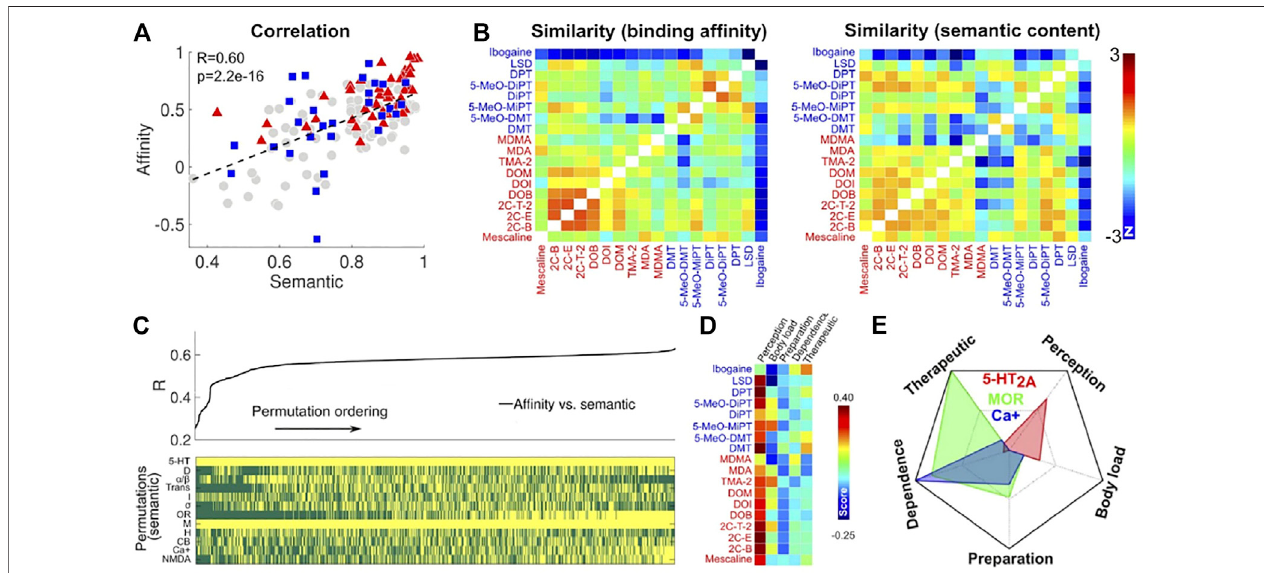
FIGURE 6 | The semantic similarity of subjective reports is correlated with the similarity of binding af fi nity pro fi les for 18 psychedelic tryptamines and phenethylamines (panel (A) , left), from Zamberlan et al., 2018. This can be appreciated by direct visual inspection of the corresponding similarity matrices (panel (A) , right). Panel (B) shows the correlation (with the color code representing Z scored correlations) between semantic and pharmacological similarity matrices, with the latter computed using information from different receptor subsets, allowing to identify an optimal group of receptors to explain the semantic content of the reports. The principal components of the reduced ranked term-document matrix represent recurrent topics in the corpus, with variable prevalence among the psychedelic drugs under study (panel (D) ). In this panel, the color code indicates the load of each LSA topic in the reports associated with each compound. This type of analysis is also capable of linking af fi nity to certain receptors with speci fi c topics (panel (E) ), e.g., 5-HT2A with the “ perception ” topic, or MOR with the “ dependence ” and “ therapeutic ” topics (5-HT2A: serotonin 2A receptor, MOR: opioid receptor, Ca+: Calcium ion